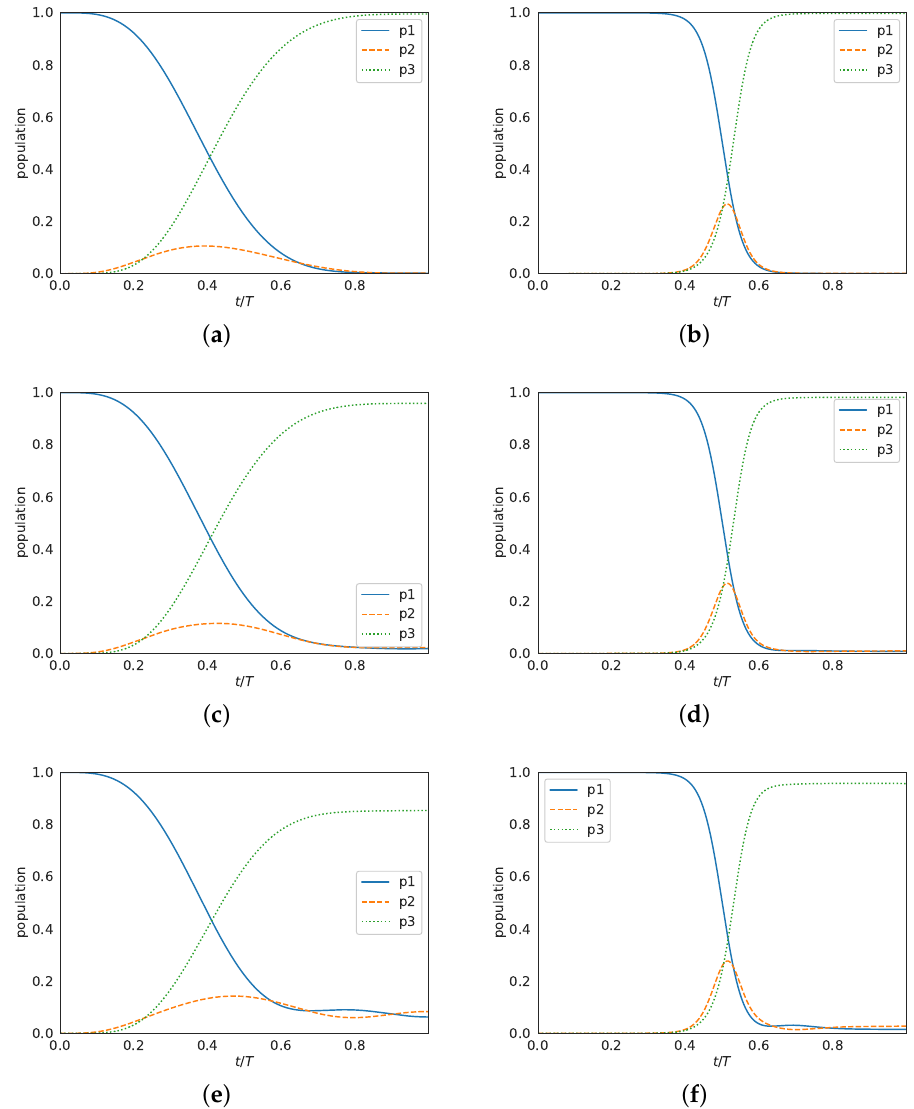
Figure 8. Evolution of populations in the interval 0 ≤ t ≤ T for the shortcut pulses displayed in Figure 1a (first column), Figure 2a (second column), and different values of the noise correlation time: ( a , b ) τ c / T = 0.008, ( c , d ) τ c / T = 0.08, and ( e , f ) τ c / T = 0.8. These results are obtained after averaging over many simulation instances. The trajectories do not exhibit a high-frequency “noisy” behavior, since the power of the considered noise processes is concentrated in lower frequencies, affecting only the final